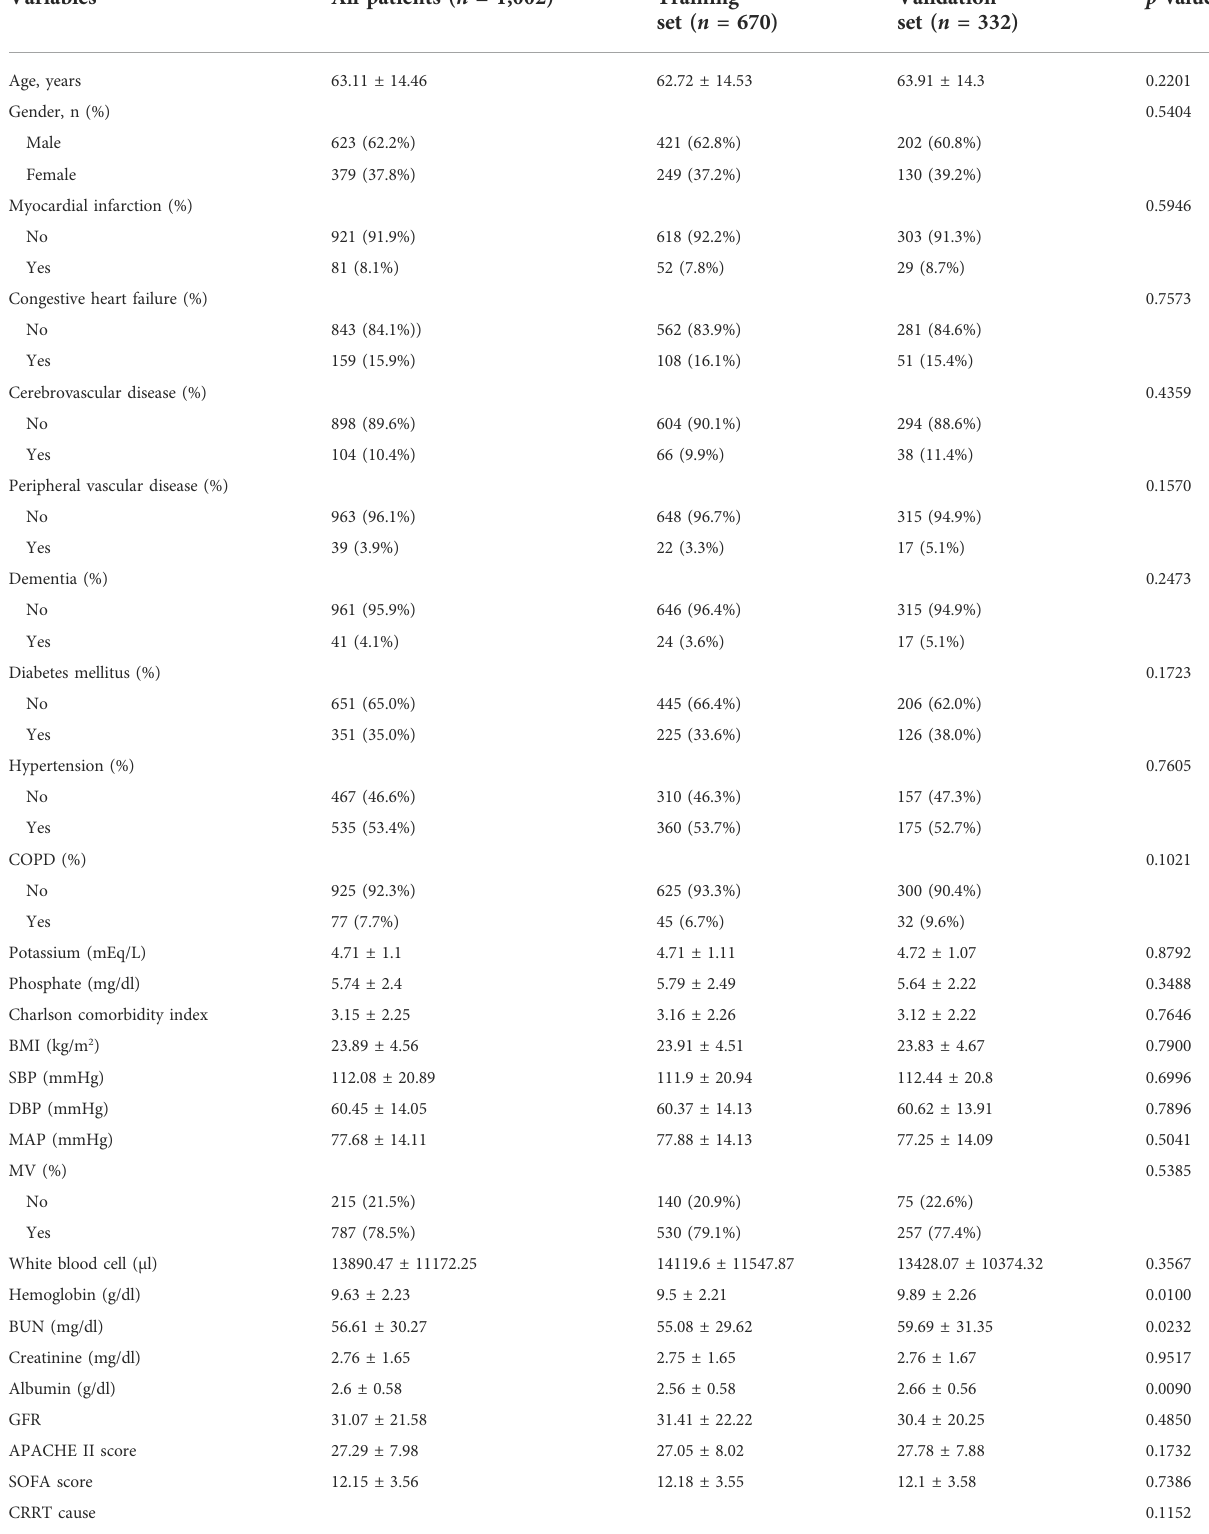
TABLE 1 Baseline demographics and clinical characteristics of patients in training cohort and validation